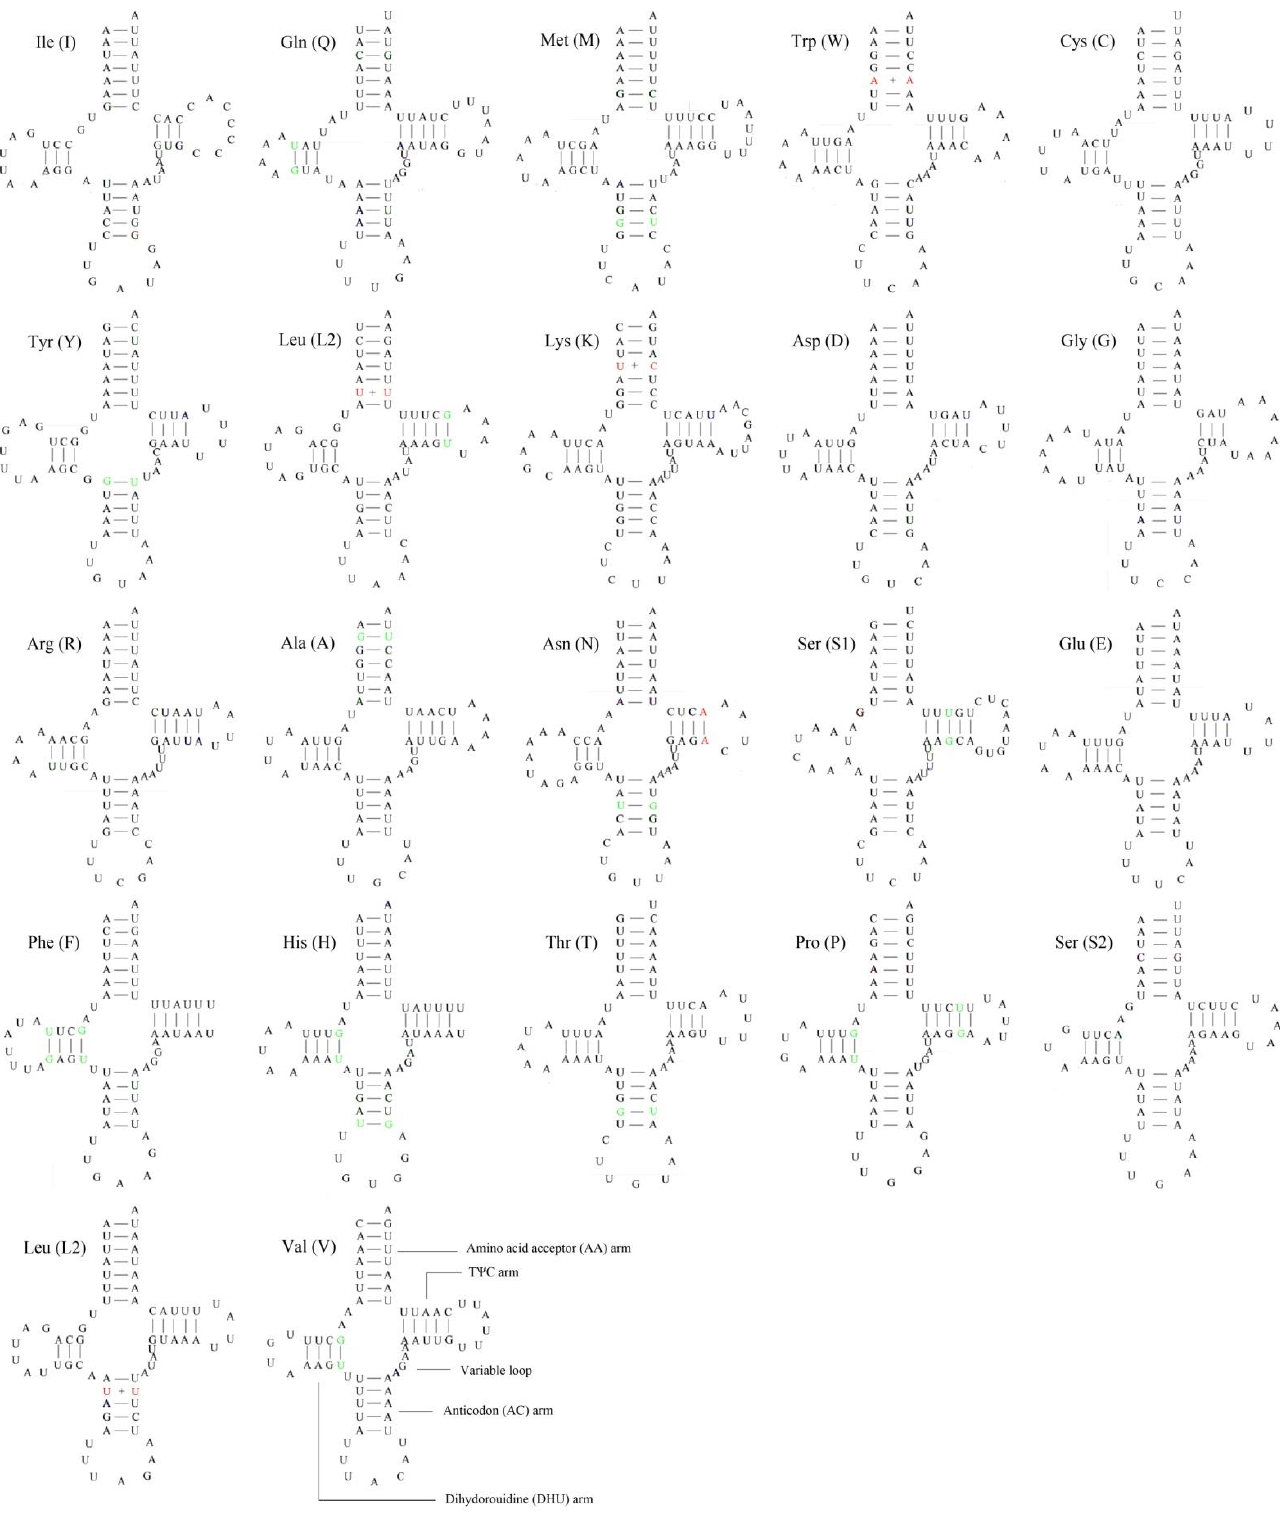
Figure 4. Putative secondary structures of tRNAs from Cordylepherus sp. mitogenome (noncanonical base pairings in green; mismatched base pairs in red).